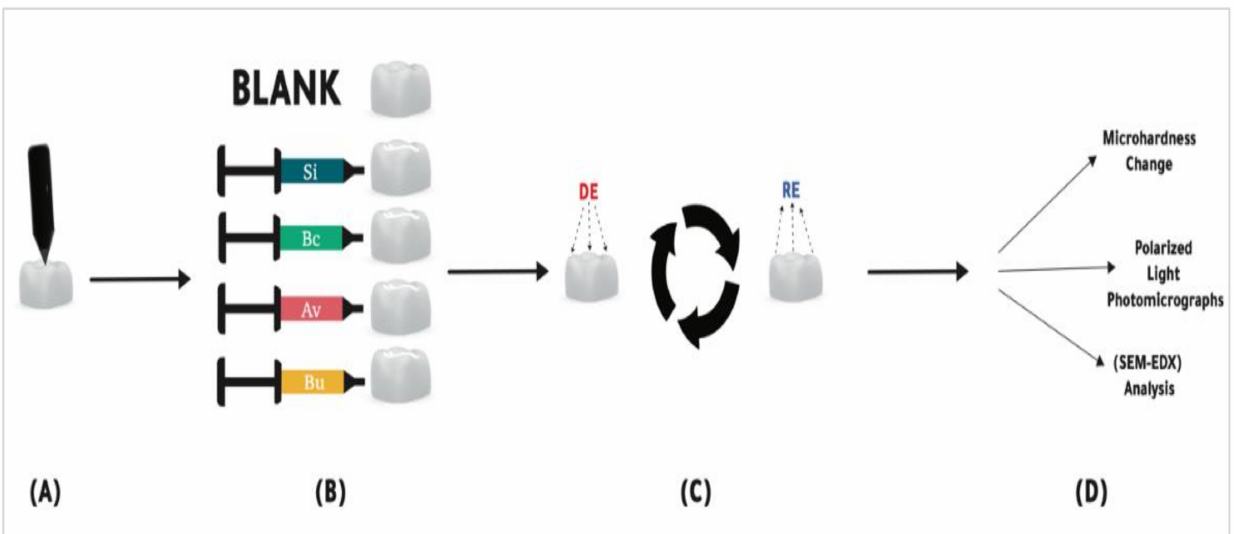
Figure 1. A diagram illustrating the remineralization abilities assessments’ experimental design. ( A ) The baseline Knoop hardness test of enamel samples. ( B ) The samples were sealed with different commercially available sealants and one group was left as the blank group. ( C ) The samples were sub- jected to pH-cycling for 7 days. ( D ) Final hardness measurements polarized light photomicrography and SEM-EDX analysis were